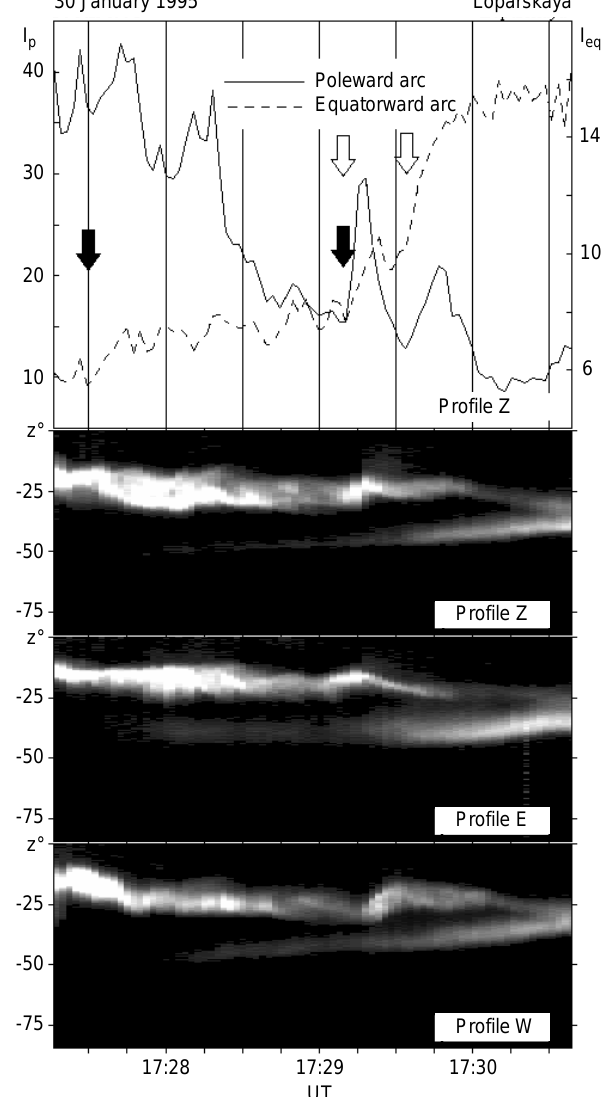
Fig. 3. Variations of the luminosity in two auroral arcs and grey-coded keograms for the MAAS interval on 30 January 1995. I means the mean value of the sky luminosity in the interval of zenith angles occupied by the arc (arbitrary units), subscripts ‘‘ p ’’ and ‘‘ eq ’’ correspond to poleward and equatorward arc, respectively, Z is the zenith angle. Black arrows show the beginning of OP events, open arrows show the beginning of IP events